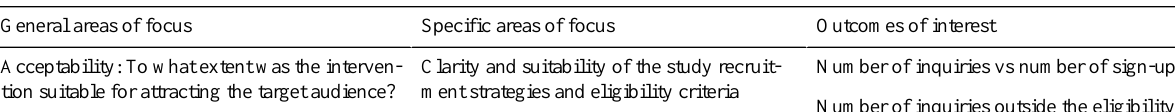
Table 1. Study feasibility foci and outcomes of interest (adapted from Bowen [44]).